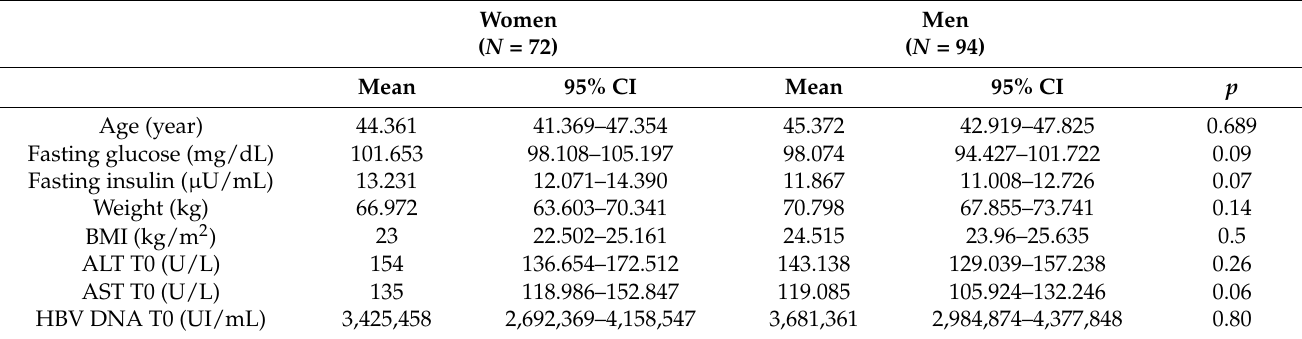
Table 1. The synoptic characterization of the group. BMI: body mass index; ALT: alanine aminotransferase; AST: aspartate aminotransferase; HBV: hepatitis B